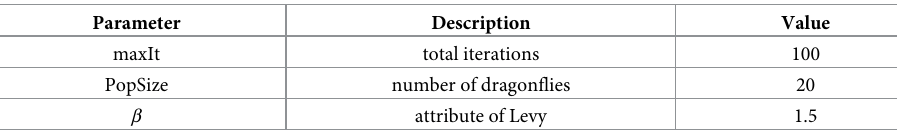
Table 1. Parameter values of